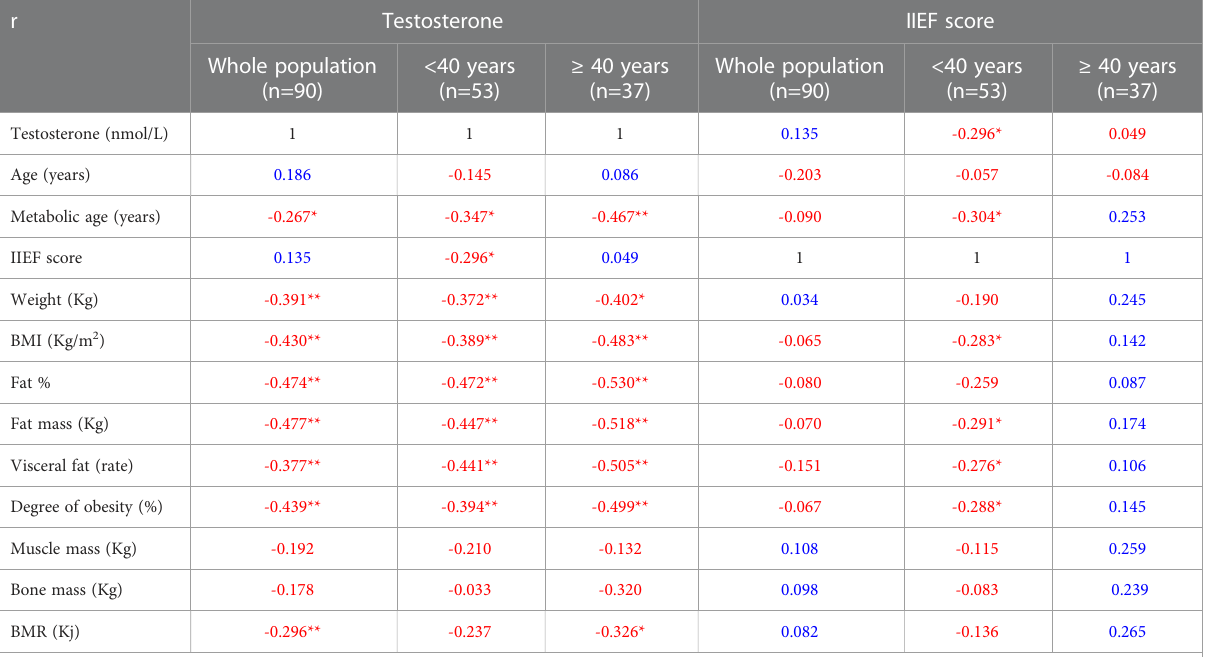
TABLE 2 Pearson correlation between variables in the whole study population and the subjects < or ≥ 40 years